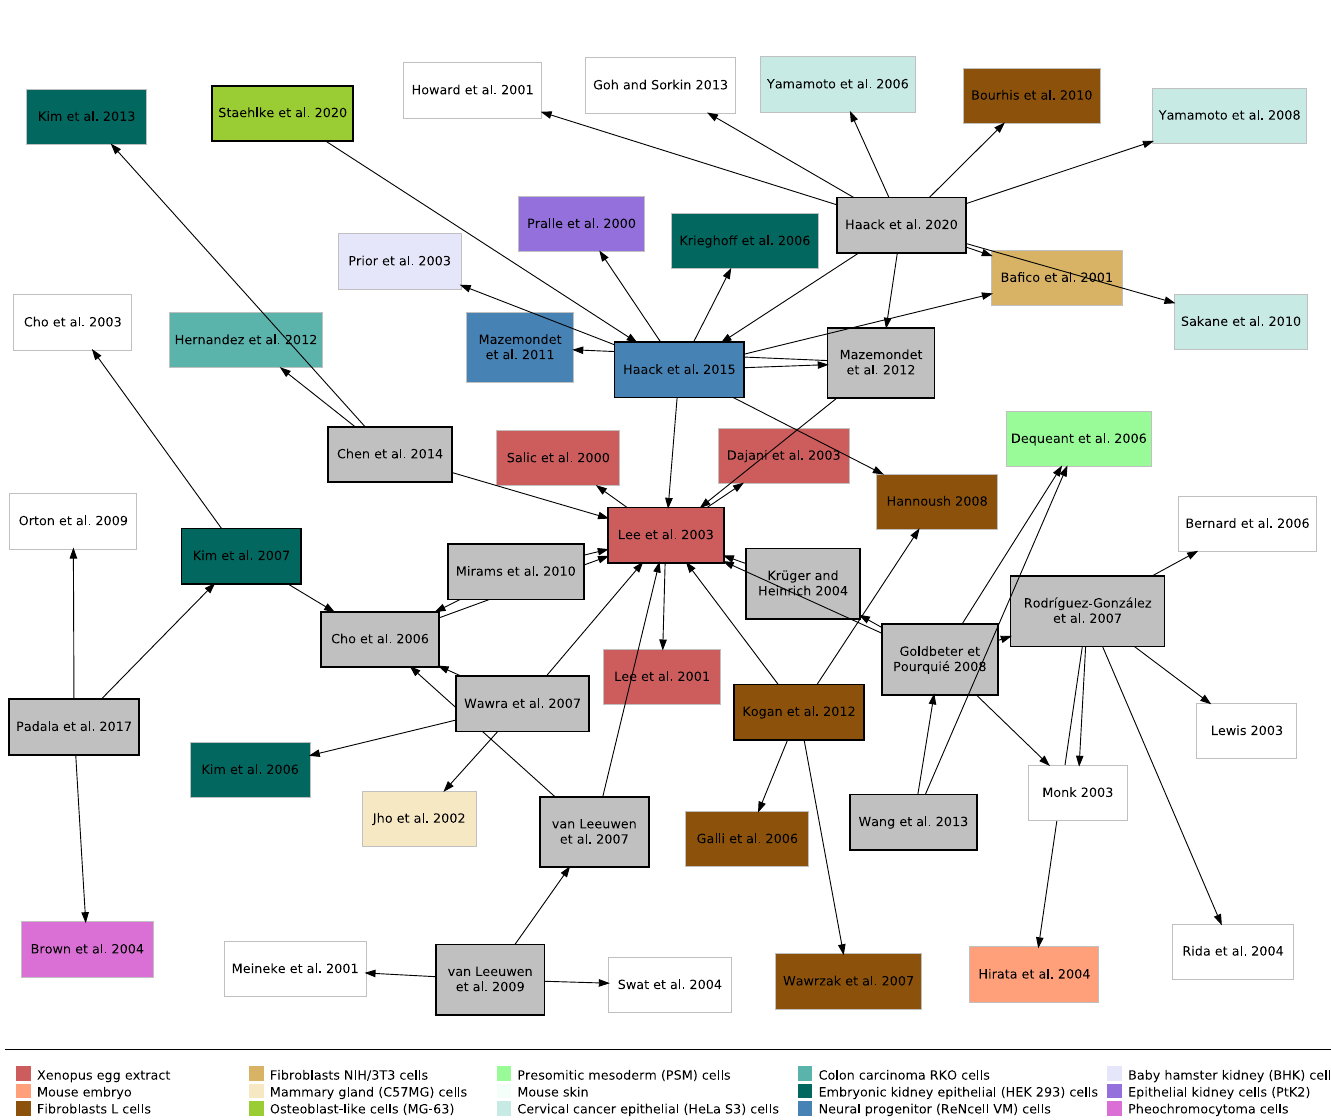
Fig 6. Provenance graph of all Wnt/ β -catenin simulation studies considered here (black outlines) as well as additionally used studies (gray outlines). The colors indicate the cell lines used in wet-lab experiments of that study (see legend below graph). Gray boxes represent pure Wnt/ β -catenin simulation studies without acquiring wet-lab data. White boxes display publications used by some of the Wnt/ β -catenin simulation studies that are either text books or simulation studies without published wet-lab data. The figure was created using the R package DiagrammeR [103]. The references to the additionally used studies are found in S1 Appendix.